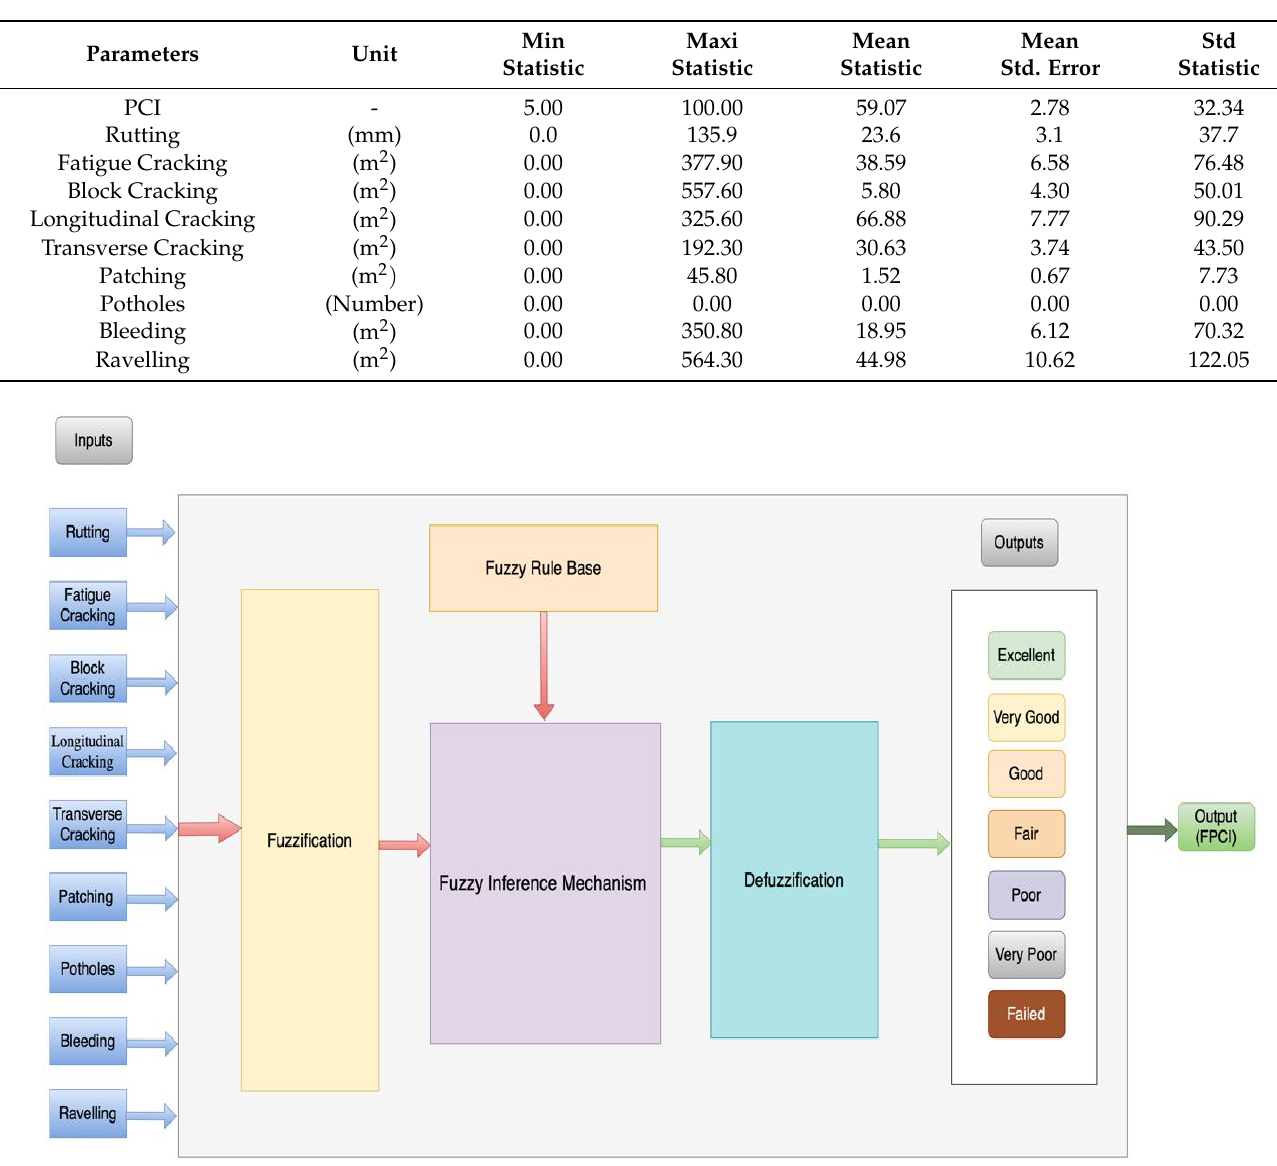
Figure 3. Structure of the fuzzy logic approach to the PCI.